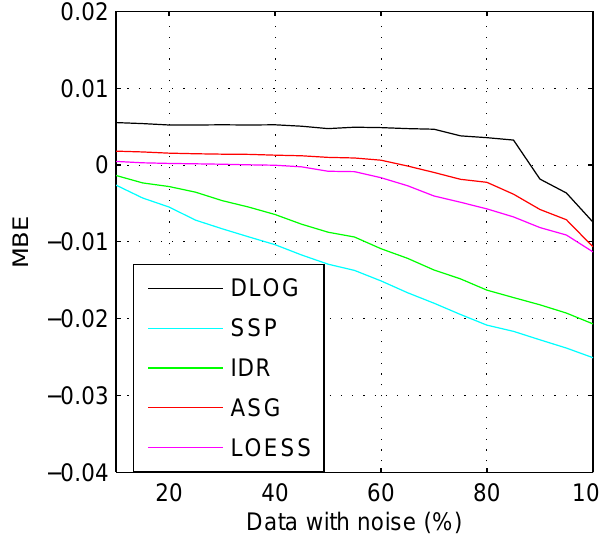
Figure 4. Performance of the applied filtering methods in terms of bias (MBE) averaged over the nine